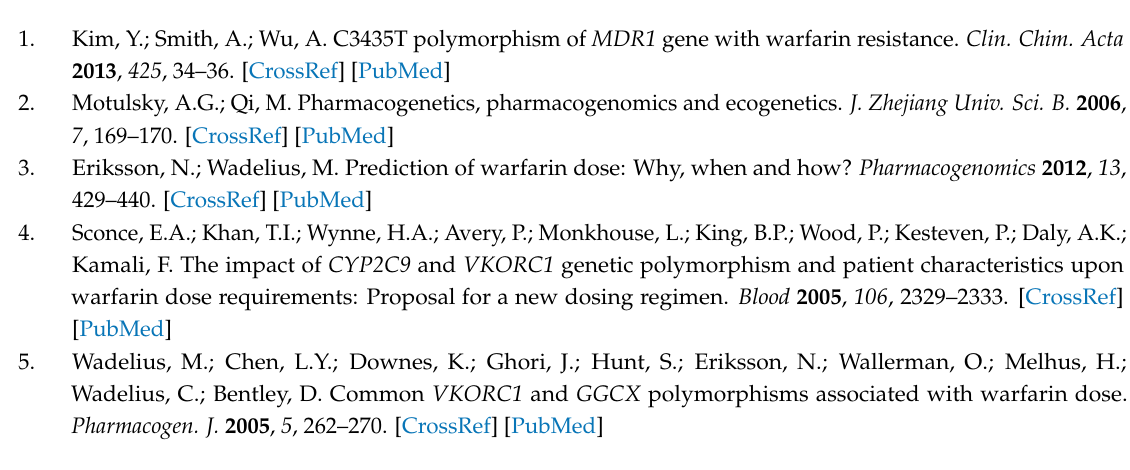
Table S1: SNPs ID, their position and genotyping data based on whole cohort ( N = 220). Table S2: List of SNPs, their minor allele frequencies, and HWE p values for genotypic distribution at each locus based on 220 patients. Table S3: The frequency of the allele and genotype for all polymorphisms in cardiovascular patients treated with